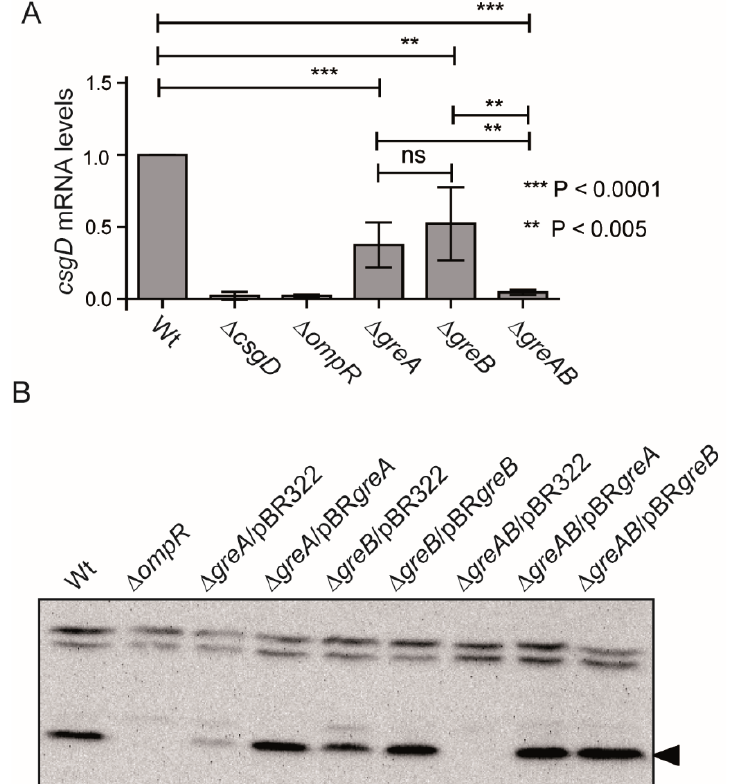
Figure 2. The expression of csgD encoding the master regulator of rdar biofilm formation is impaired in the absence of the Gre factors. ( A ). csgD mRNA levels were determined by qPCR in RNA samples from cultures of the indicated strains grown on LB 0 plates at 28 °C for 24 h. Results are normalized to expression of recA as an endogenous control and given as relative values to Wt, arbitrarily set as 1.0. The results are mean and standard deviation from three biological replicates. Statistical significance is indicated by *** p < 0.0001, ** p < 0.005, ns: non-significant. ( B ). Immunodetection of CsgD (indicated by an arrowhead). Cell extracts from cells grown on LB 0 plates at 28 °C for 24 h were separated by PAGE and analyzed by Western blot analysis.